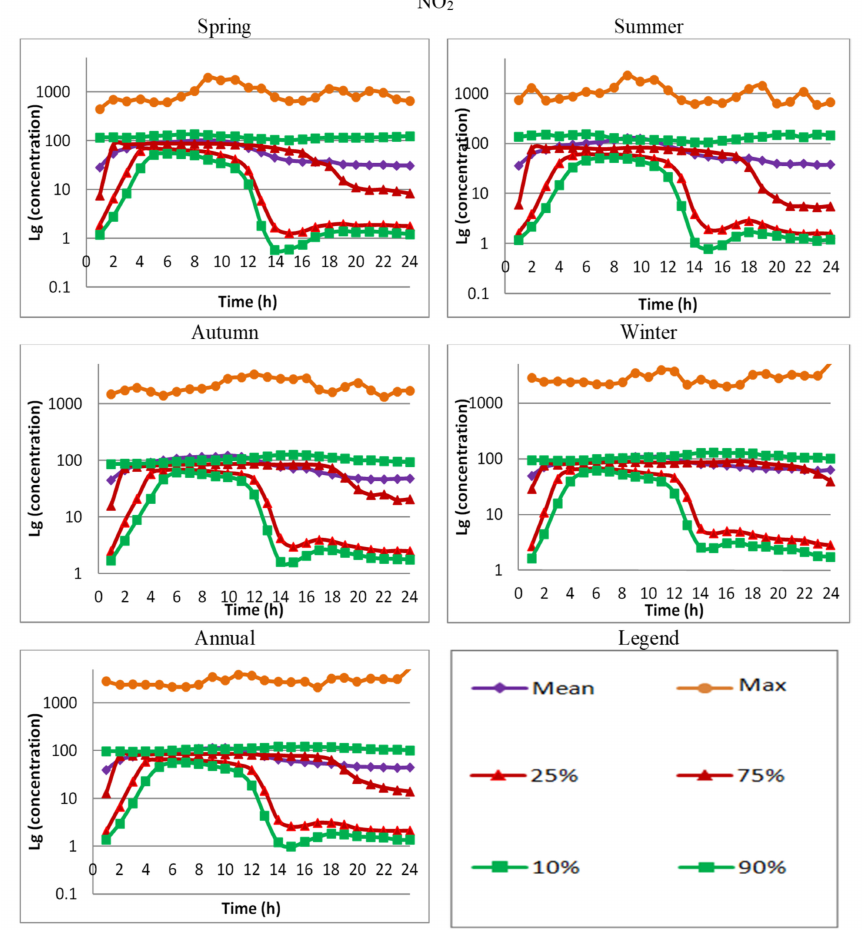
Figure 14. Spatial and diurnal variations of the annual and seasonal ensembles of surface NO 2 ( µ g/m 3 ) concentrations behavior in logarithmic scale for Bistritsa for the period 2008–2014.